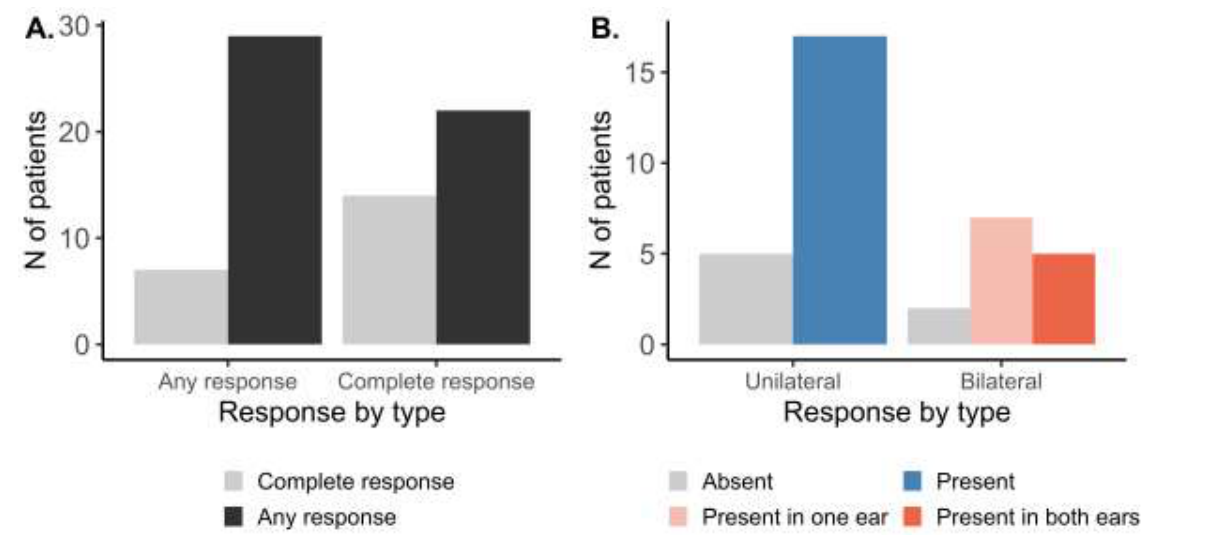
Figure 2. Patient level response to the AMSA treatment stratified by ( A ) completeness or ( B ) laterality of OME.